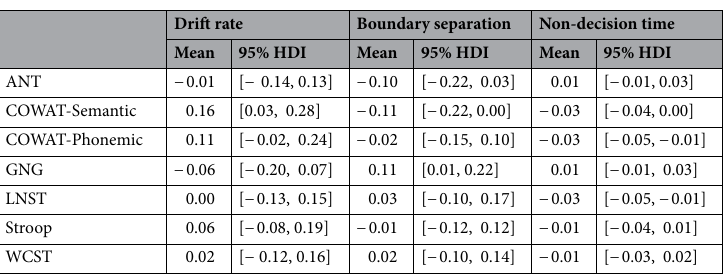
Table 3. Posterior means and 95% HDIs of decision parameters with regard to seven neuropsychological test performances. ANT attention network test, COWAT controlled oral word association test, GNG go/no-go, LNST letter number sequencing task, WCST Wisconsin card sorting test, HDI highest density